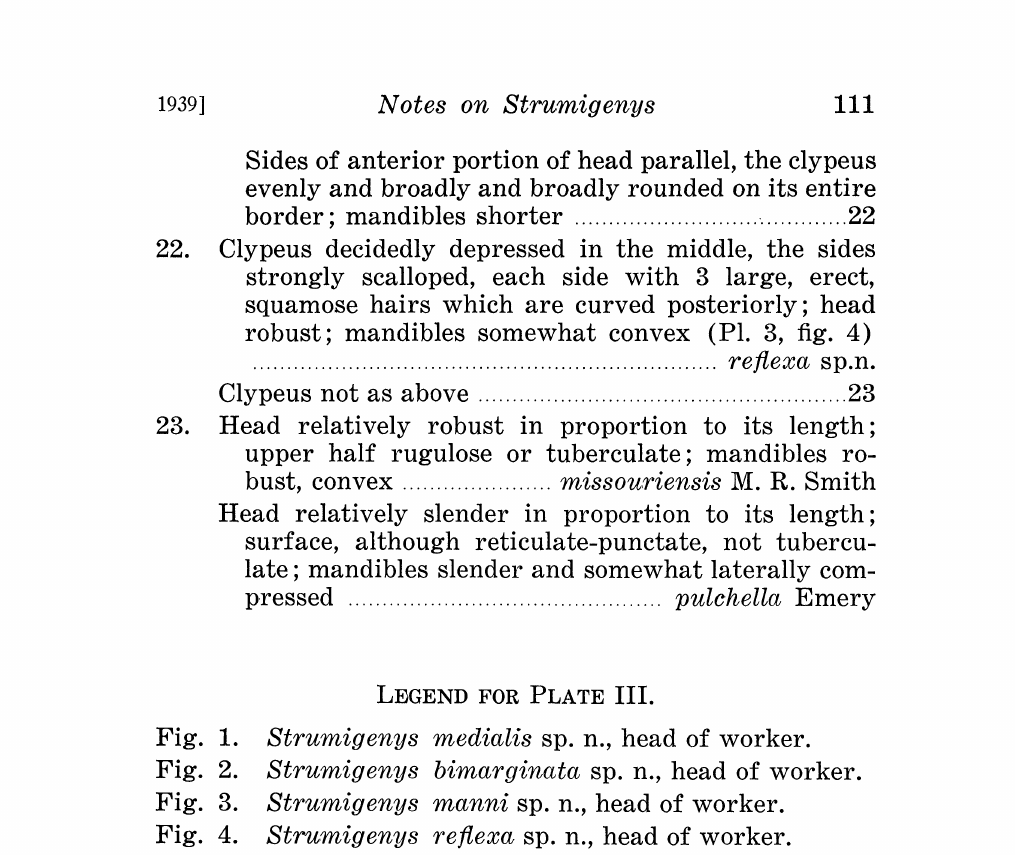
LEGEND FOR PLATE